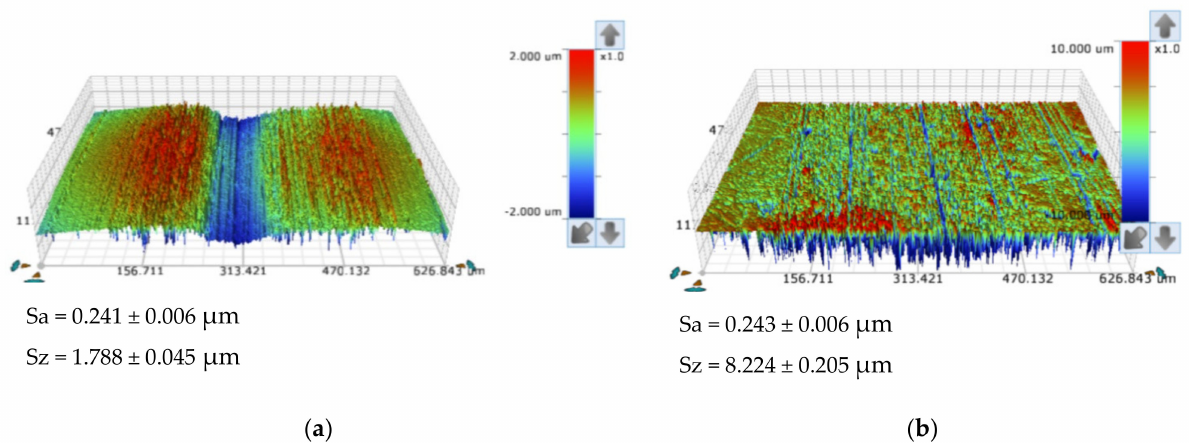
Figure 21. Representative images of the optical profilometry of the rail surface of the test balls for alumina powder (1 µ m), load 0.5 N: ( a ) AISI 52100; ( b ) SS AISI 304.